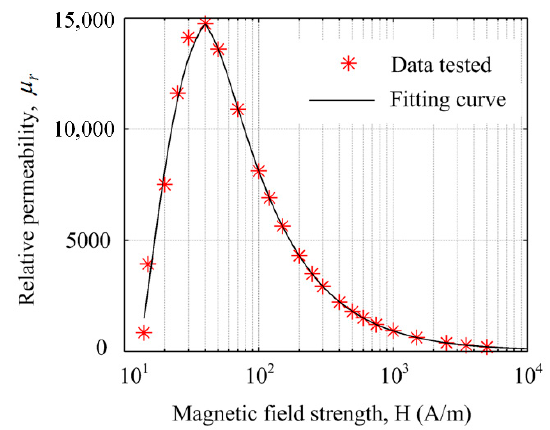
μ μ curve of pure iron material. curve of pure iron material. r r